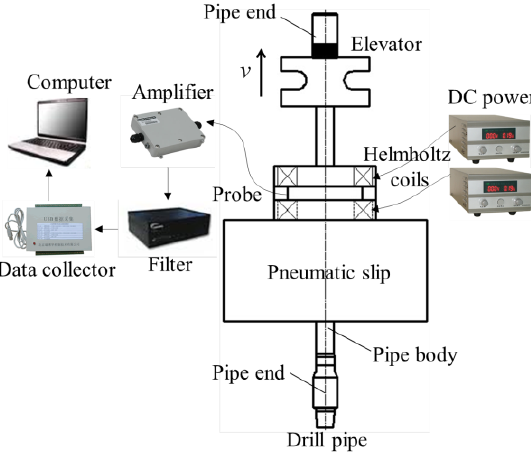
Figure 3. The diagram of the MFL (magnetic flux leakage) method for drill pipes at the wellhead.